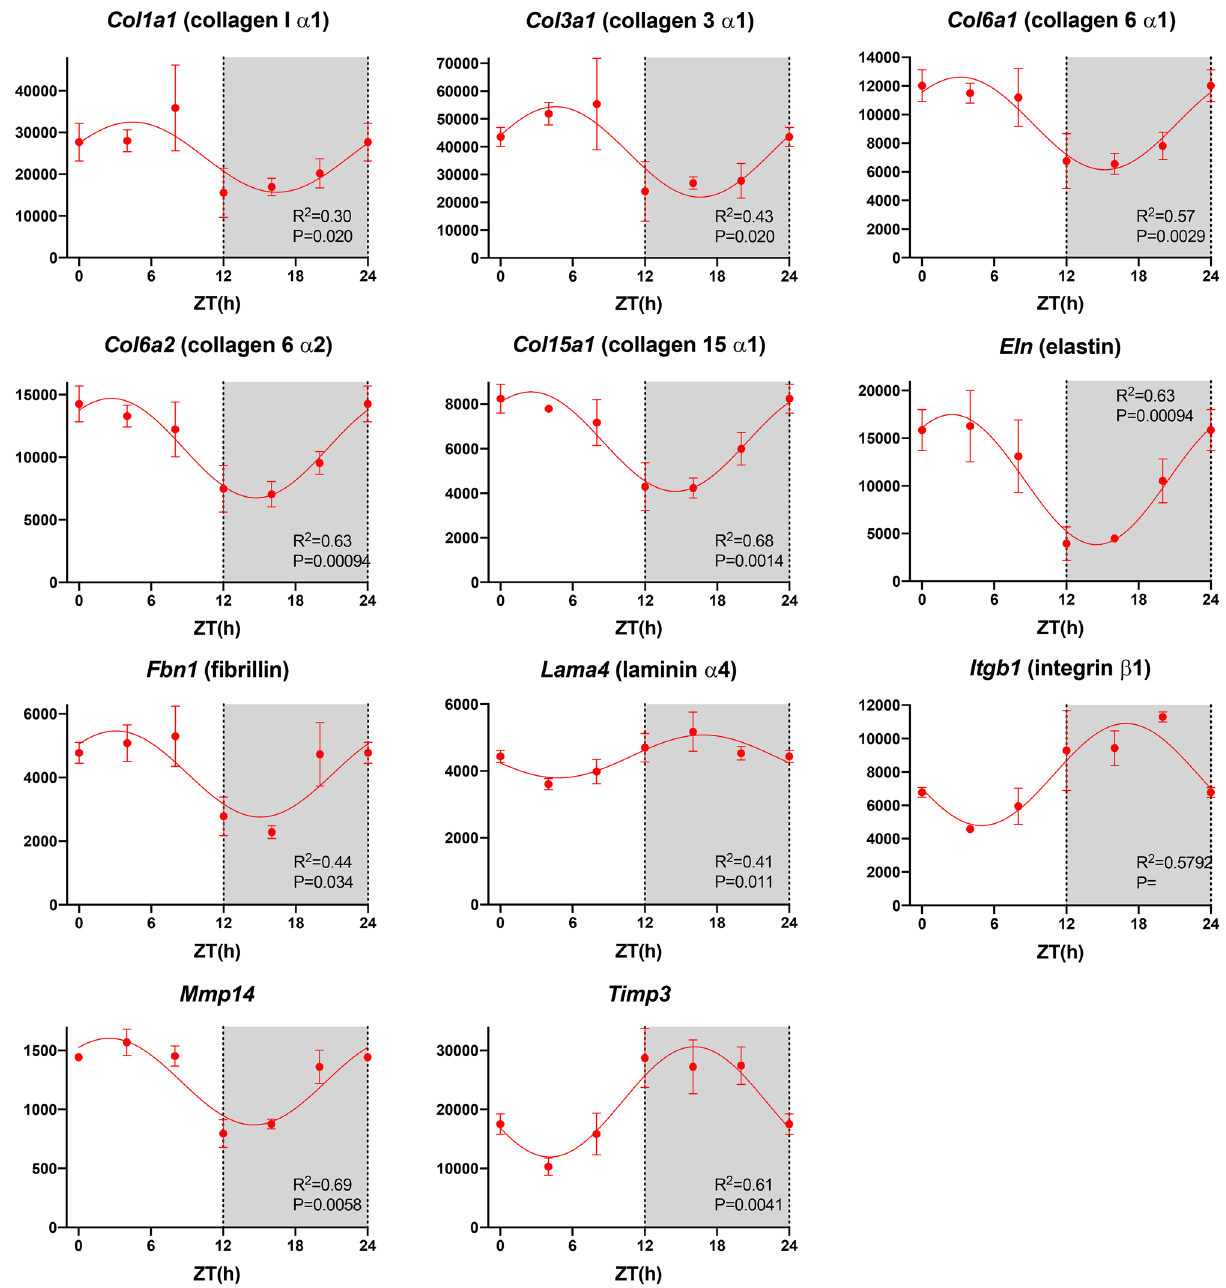
Figure 6. Extracellular matrix. Abundance (normalised counts) of example extracellular matrix transcripts is shown over 24 h. See Fig. 1 legend for further